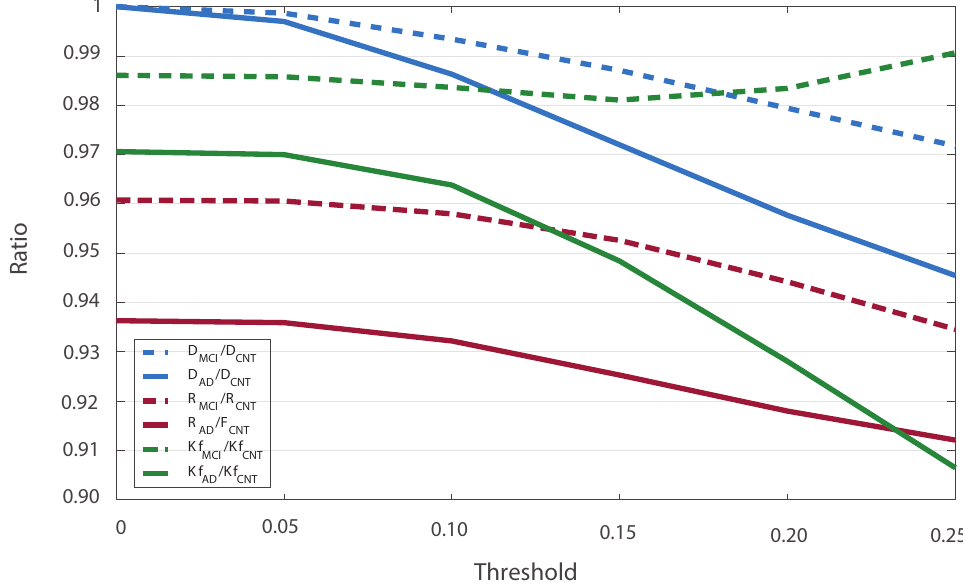
Figure 7. Trend of the three indexes’ performance, reported in Table